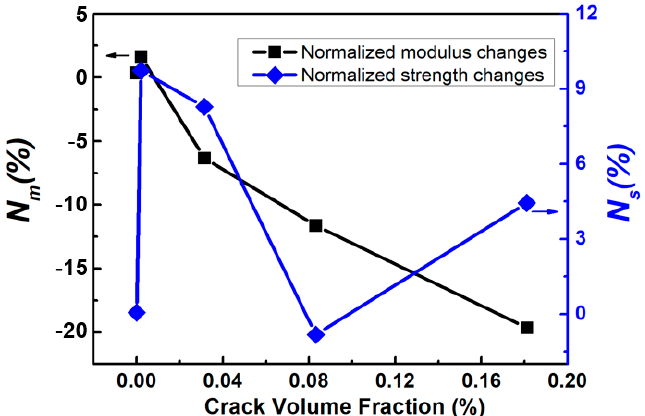
Figure 13. Normalized tensile properties changes vs. the CVF, showing the effect of microcracks.